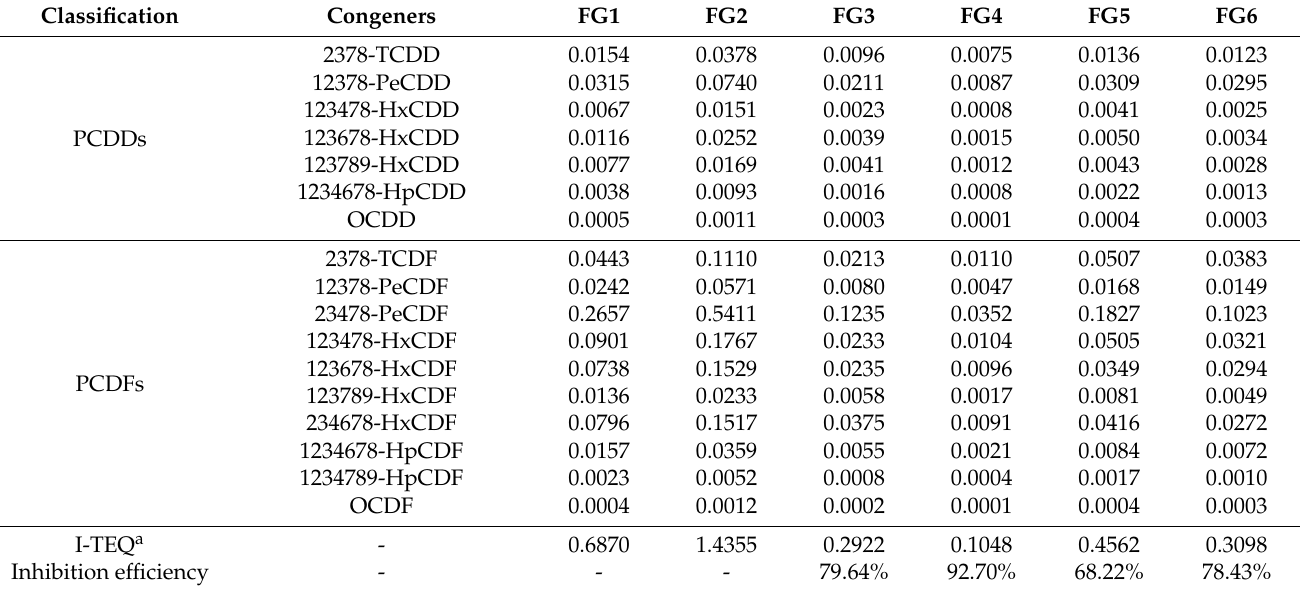
Table 4. The I-TEQ concentrations (ng I-TEQ/Nm3) of PCDD/Fs for six experimental flue gas